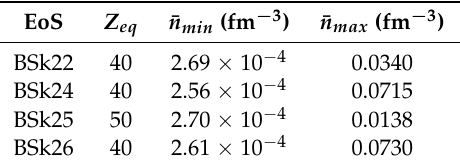
Table 1. Principal values of Z eq in the inner crust below proton drip for BSk22, BSk24, BSk25 and BSk26. Here ¯ n min and ¯ n max are the minimum and maximum baryon number densities, respectively, at which the nuclide is